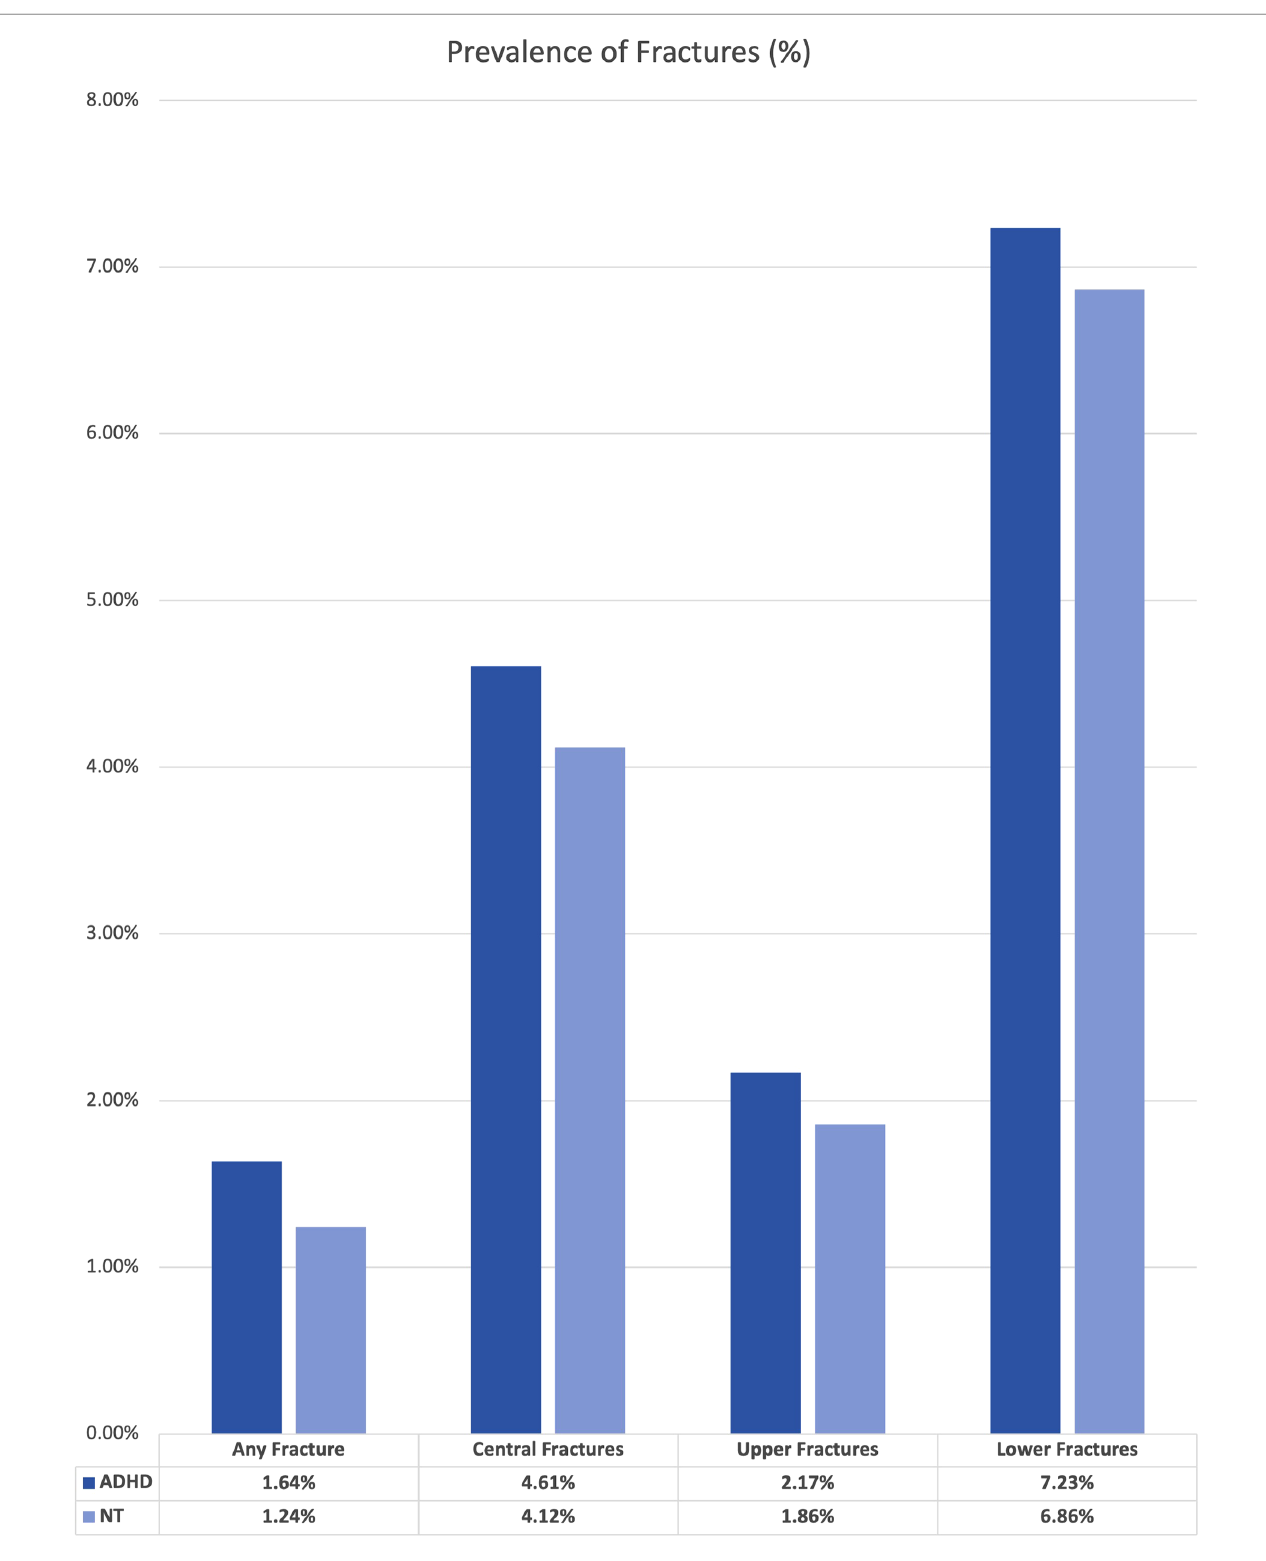
FIGURE 1 Absolute risk of fracture in overall ADHD and neurotypical